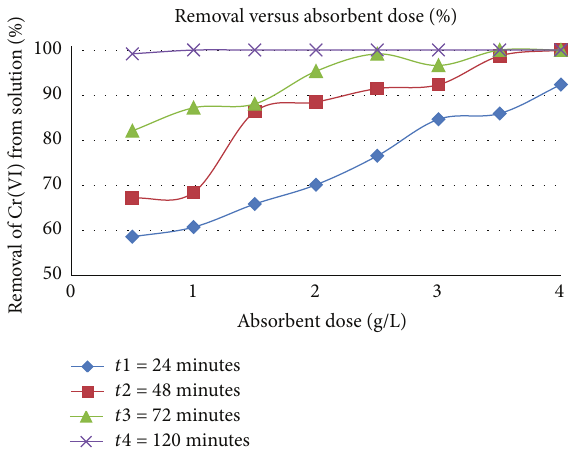
Figure1:Effectofabsorbentdoseon%Cr(VI)removalasafunction of time, pH 2.5, and initial Cr(VI) concentration of 40mg/L.